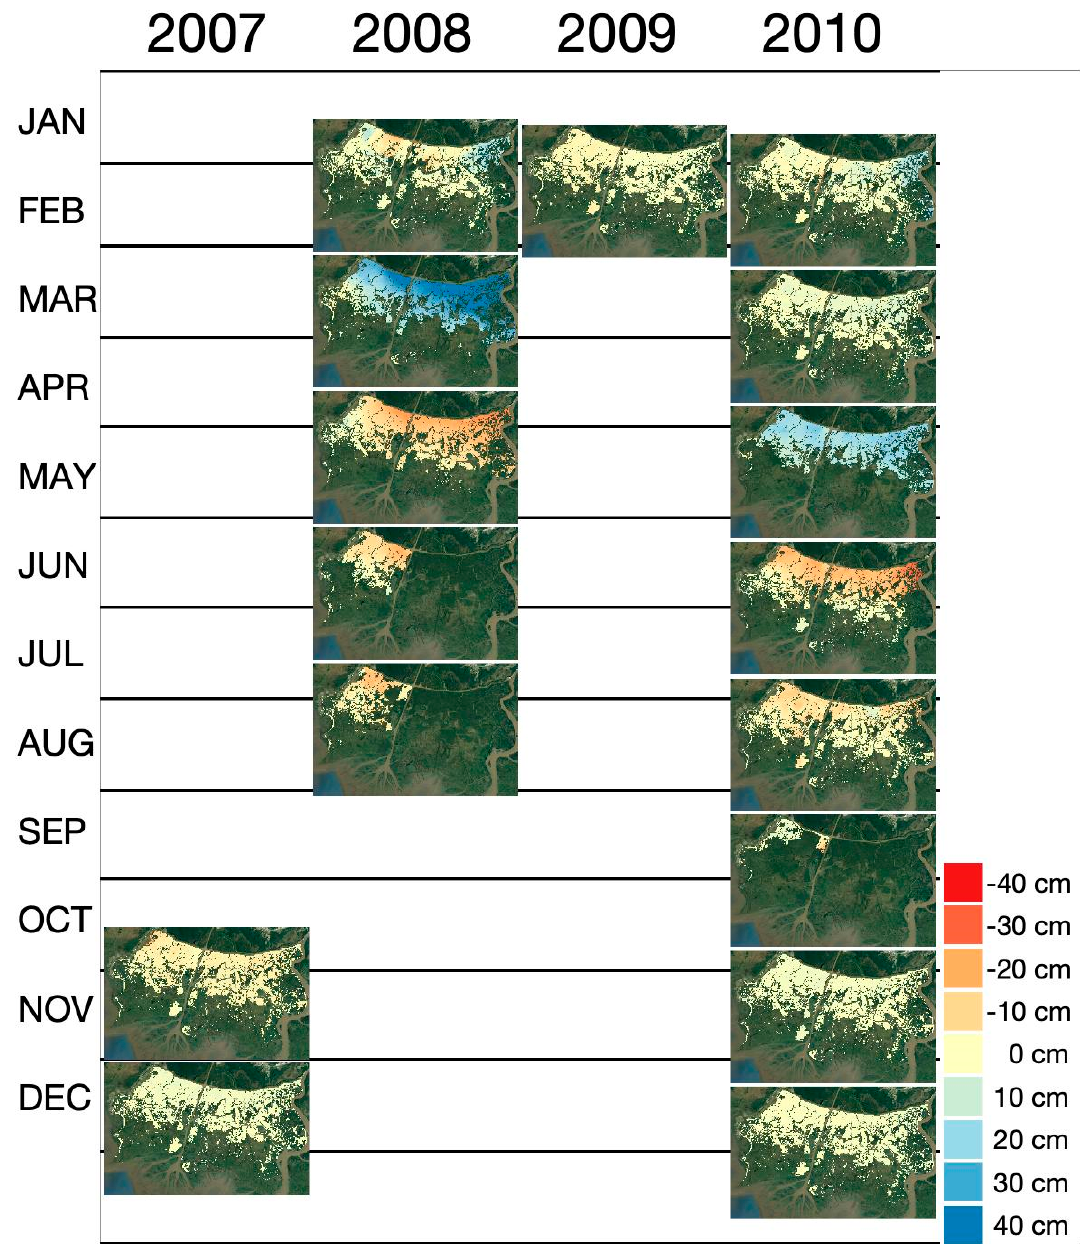
Figure 15. The calendar of retrieved water level change maps over the swamps (also within valid connected component) at Wax Lake during 2008 and 2010. The missing area for east Wax Lake in June and August 2008, is due to a lacking GCP for phase correction. (Background Map from Google